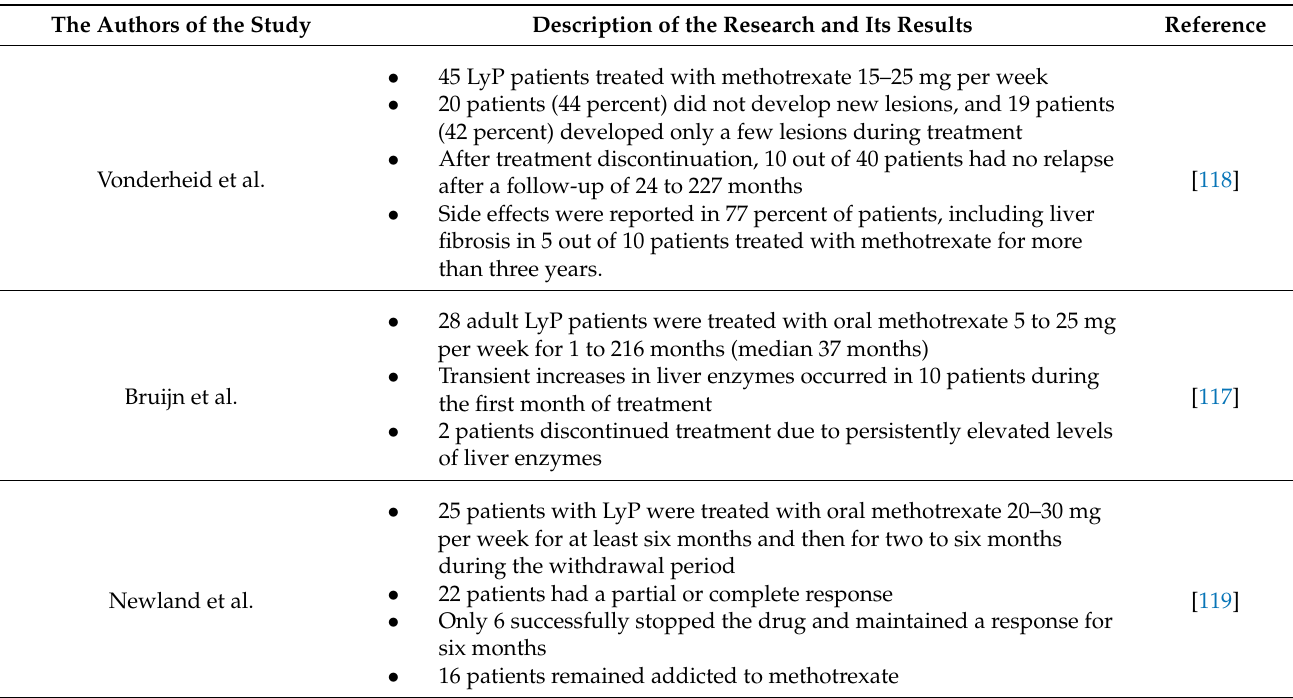
Table 3. Treatment efficacy studies with methotrexate in patients with LyP. The Authors of the Study Description of the Research and Its Results